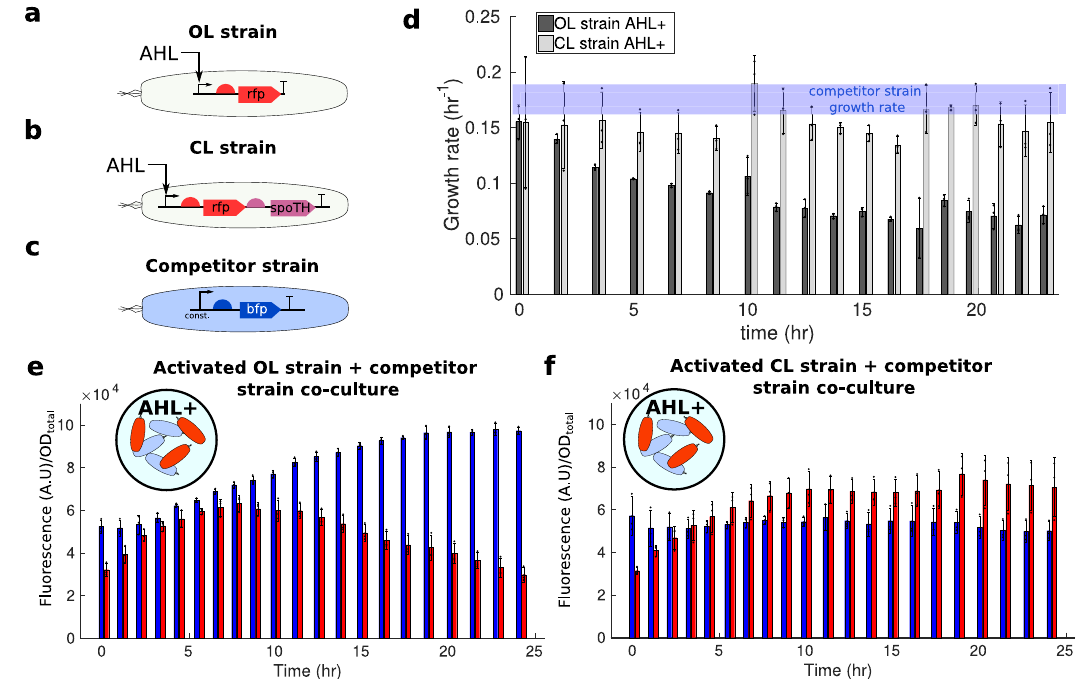
Fig. 6 | Feedforward controller promotes persistent GOI expression in a co- culture with a competitor strain. a The OL strain consists of P_OL in CF945. This strain expresses RFP using the AHL inducible Plux promoter. b The CL strain con- sists of P_IFFL_1 in CF945. This strain co-expresses RFP and SpoTH using the AHL inducible Plux promoter. c The competitor strain has P_BFP in TOP10. This strain constitutively expresses BFP. d Temporal responses of growth rate for the OL and CL strains grown in isolation post activation of the RFP gene (GOI) through AHL induction.Thegrowthrateofthecompetitorstraingrowninisolationisshownwith a blue line (see SupplementaryFig. 8 for raw data). e , f Temporalresponses ofRFP (red) and BFP (blue) fl uorescence normalized by the total OD of the co-culture